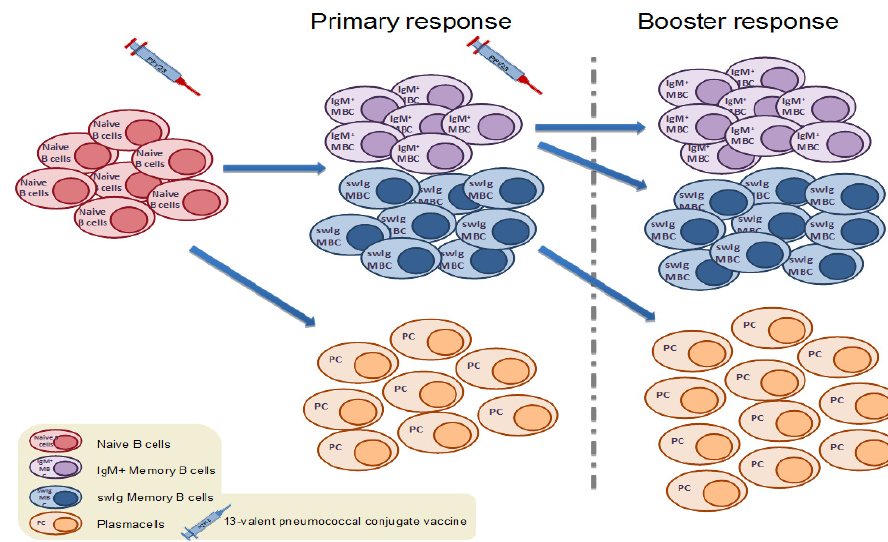
Figure 1. Upon primary vaccination with a pneumococcal conjugate vaccine (PCV), antigen-specific naïve B cells are activated following interaction with helper T cells. Some of the activated naive B cells differentiate into plasma cells, while others commit to memory and enter germinal center reactions with help from T follicular helper cells in order to generate antigen-specific IgM and switched memory B cells. Following antigen rechallenge, switched memory B cells enter rapid plasma cell differentiation, while IgM memory B cells (MBCs) enter secondary germinal center formation towards the formation of new IgM and switched memory B cells of higher affinity.